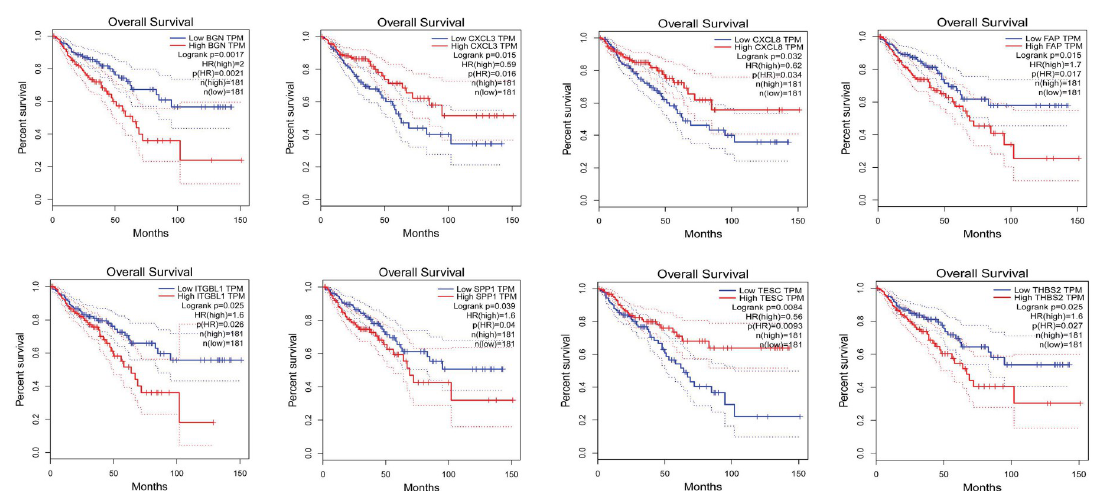
Fig 21. Kaplan-Meier plots of statistically significant over-expressed validated Differentially Expressed Genes. Each pale blue line corresponds to low expression in COAD or READ cancer types. Each pale red line corresponds to high expression in COAD or READ cancer types. The bold blue line represents some kind of average of low expression in two cancer types. The bold red line represents some sort of average of high expression in two cancer types.